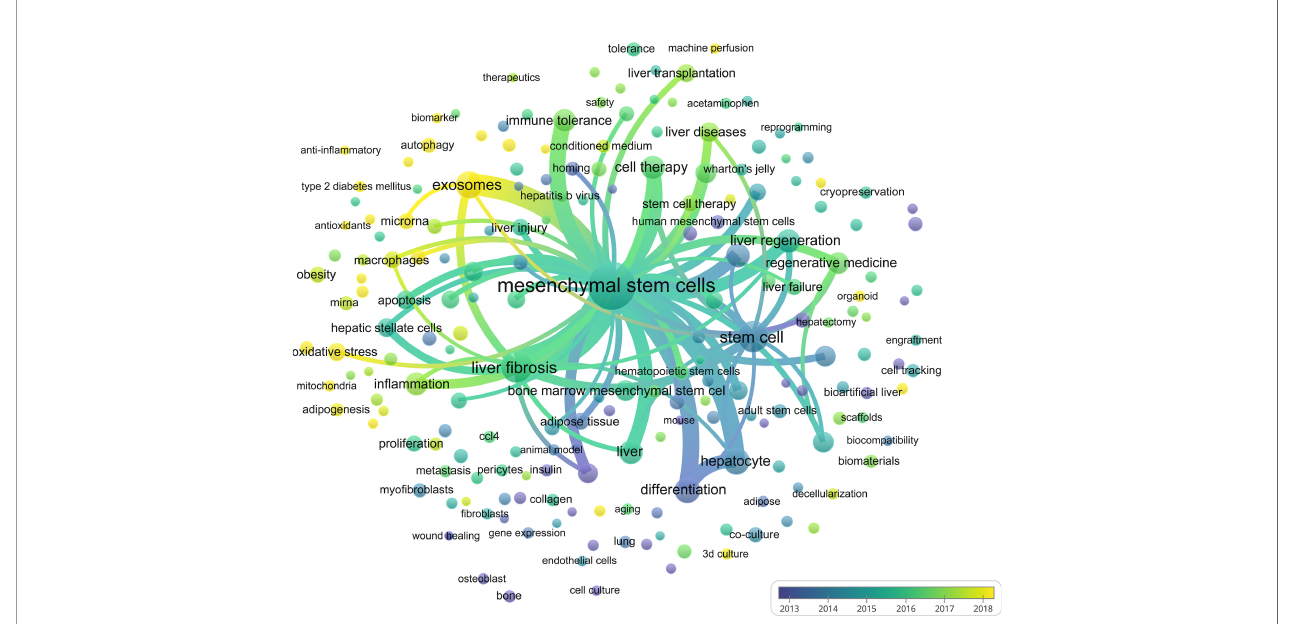
FIGURE 9 | Visual analysis of keyword co-occurrence. Different colors of the circles indicated the average year of the studies according to the bar on the lower right